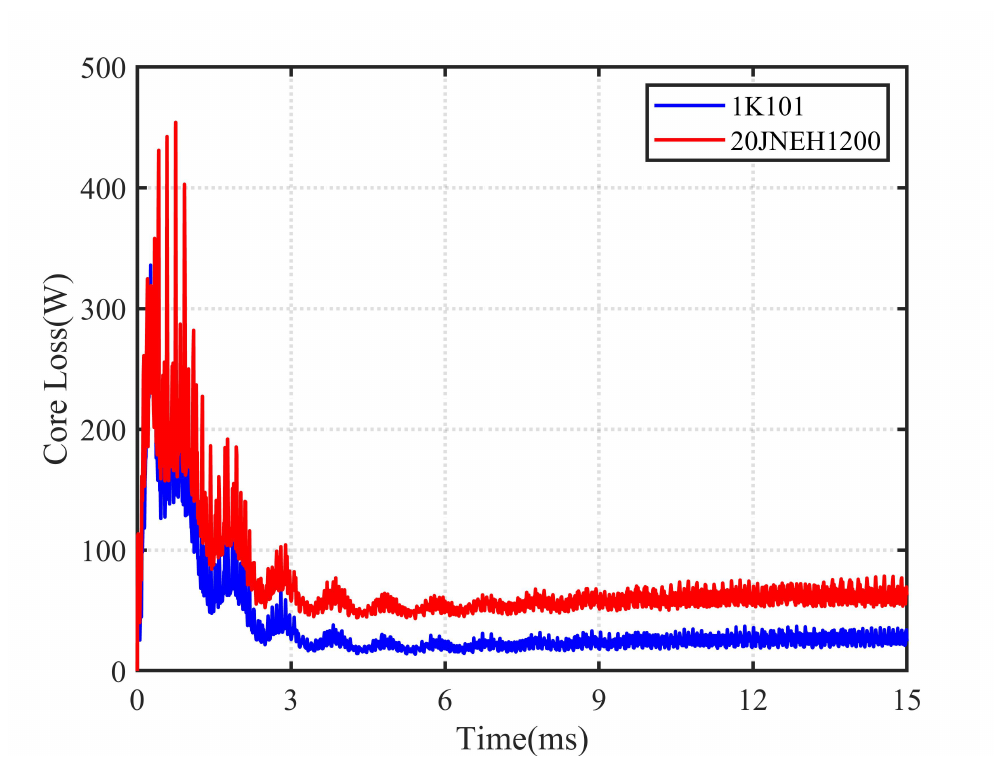
Figure 8. Comparison of the Core Loss. Table 3. Comparison of the Motor Losses.